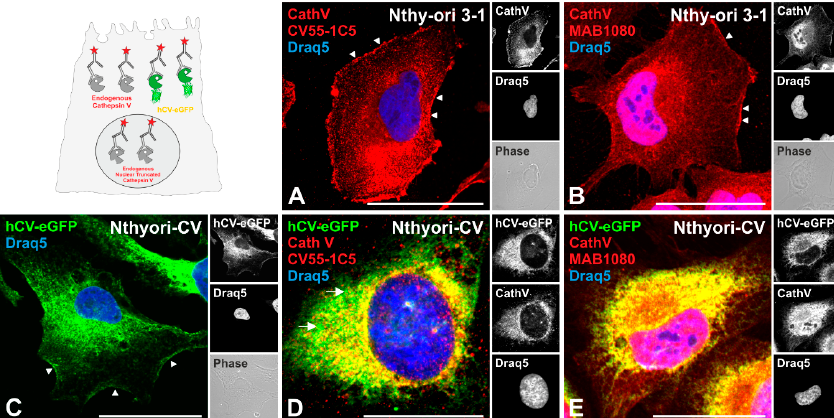
Figure 2. Subcellular localization of endogenous cathepsin V and eGFP-tagged full-length cathepsin V chimeric protein in thyroid epithelial cells. Non-transduced Nthy-ori 3-1 ( A , B ) and transduced